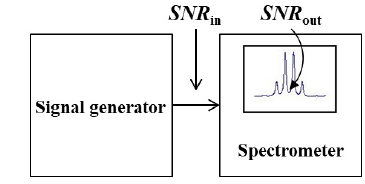
Figure A1. Spectrometer’s overall noise figure measurement: the block